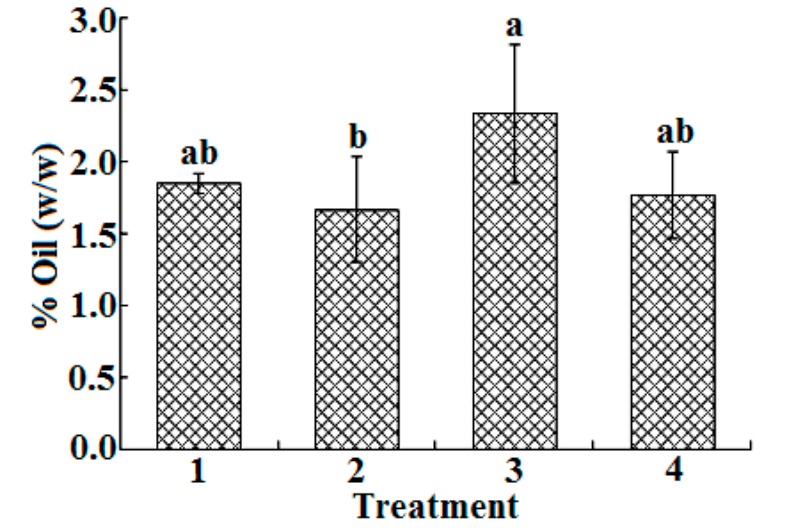
Figure 2. Total percentages of triglycerides presented in supercritical extracts of Mexican arnica. Statistical difference between treatments is denoted by letters a and b.